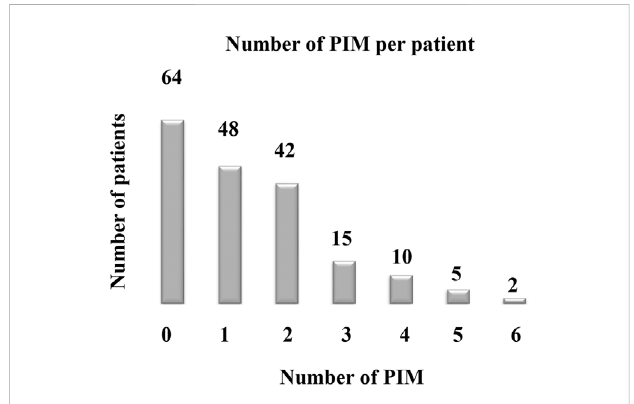
FIGURE 2 Number of potentially inappropriate medications per